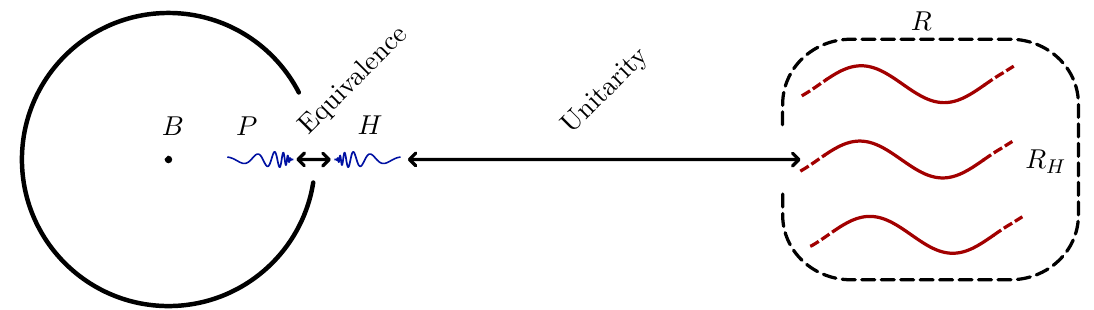
Figure 4 . Schematic depiction of the various subsystems at play in the (cid:12)rewall paradox. Arrows symbolize entanglement. De(cid:12)nitions of the other symbols are given in the